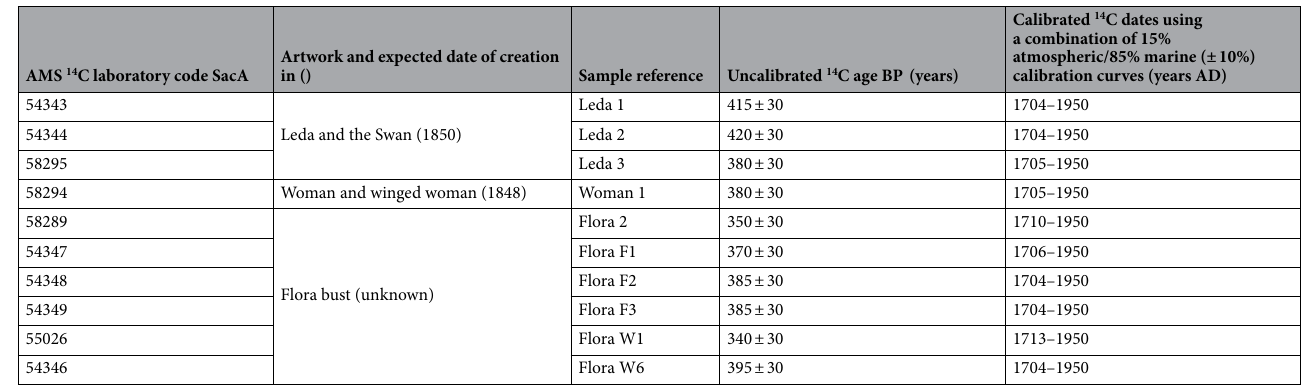
Table 3. Uncalibrated and calibrated 14 C dates for the wax samples of the Flora bust and for two wax reliefs of Lucas: “Leda and the Swan” and “Woman and winged